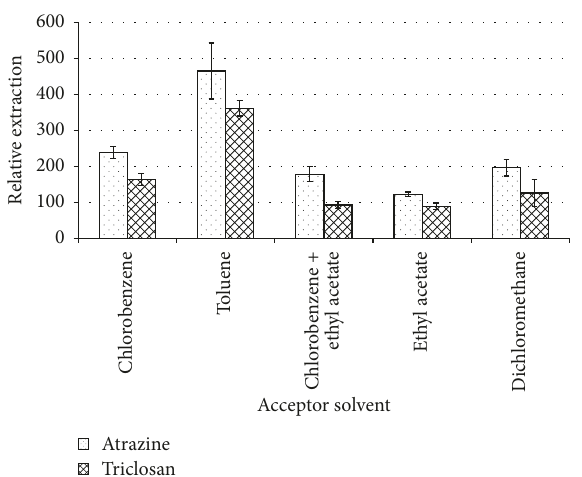
Figure 2: Effect of varying the acceptor solvent on the extraction efficiency. Conditions: volume, 1mL of 5 𝜇 g/mL atrazine and tri- closan aqueous sample; 25 𝜇 L of a 1:4 (v/v) chlorobenzene :ethyl acetate mixture with the extraction time of 20 minutes.